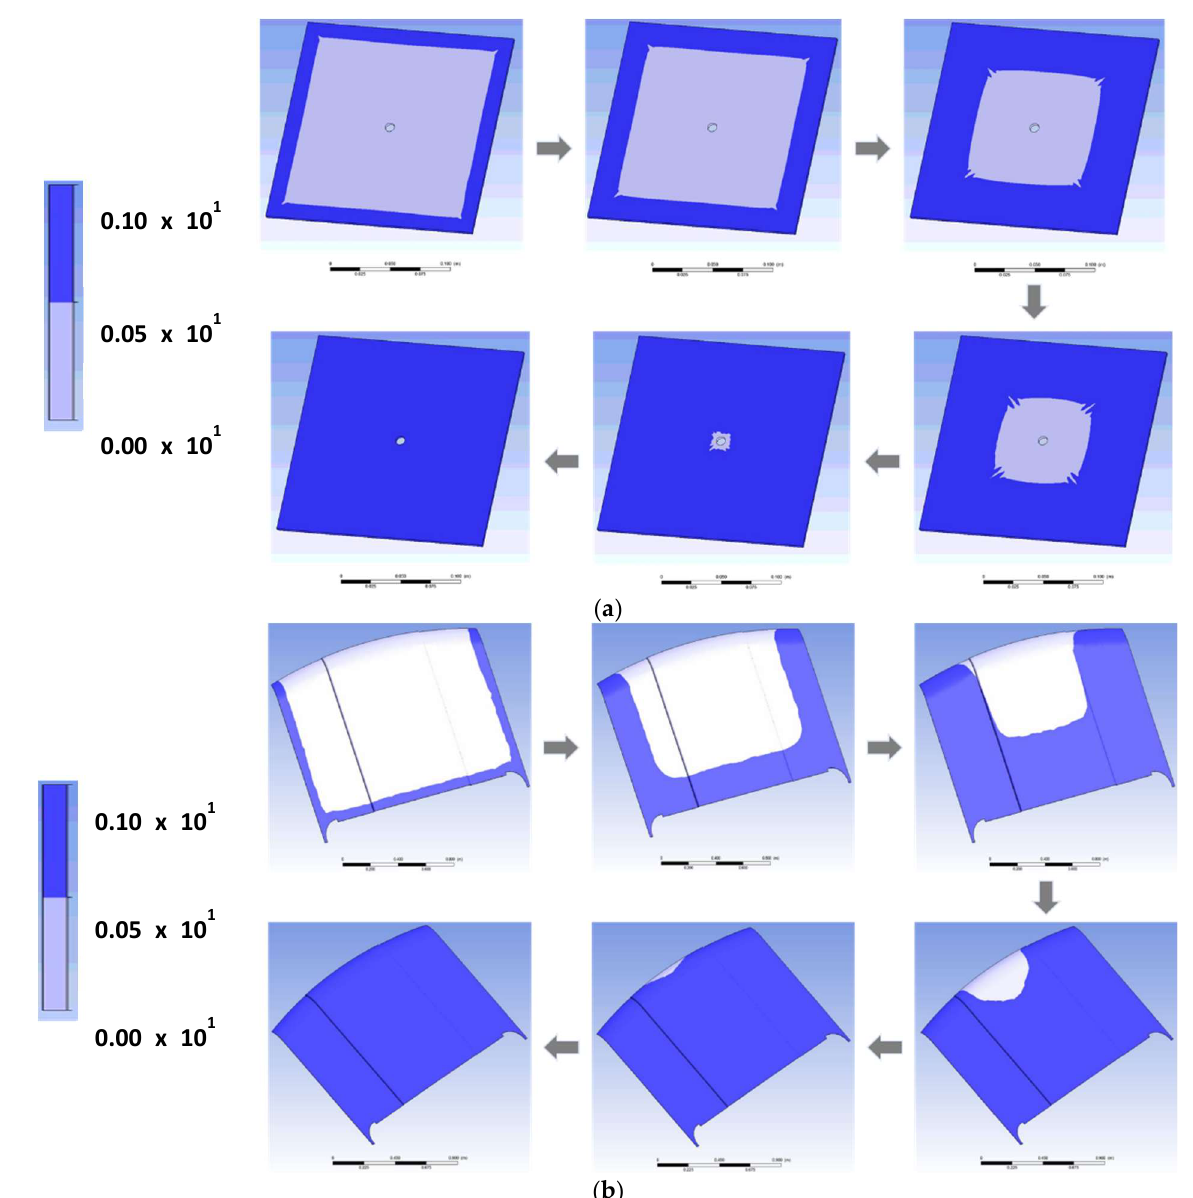
Figure 11. Phase contours (volume fraction of resin) of ( a ) rectangular mold with carbon fabrics; ( b ) automotive part with carbon fabrics.